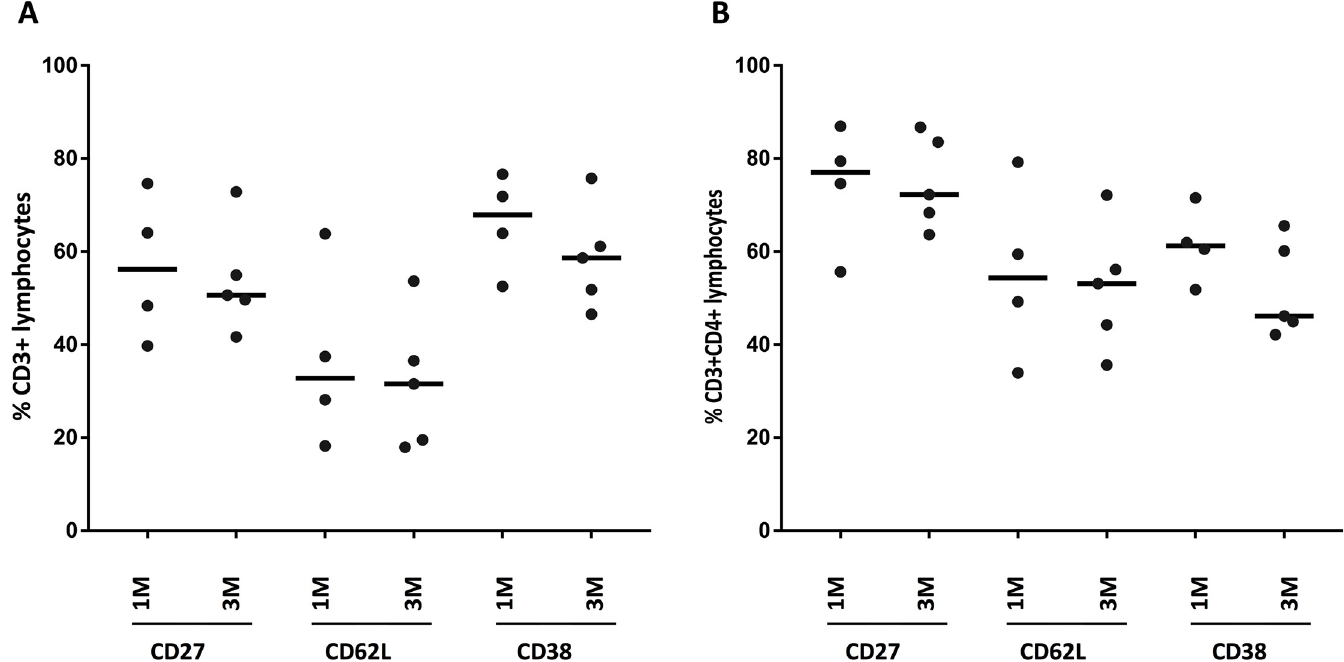
Fig 5. The proportion of (a) CD3+ and (b) CD3+CD4+ lymphocytes expressing CD27, CD62L and CD38 as determined by flow cytometry, using PBMC from a subset of HIV infected patients on ART at various timepoints.